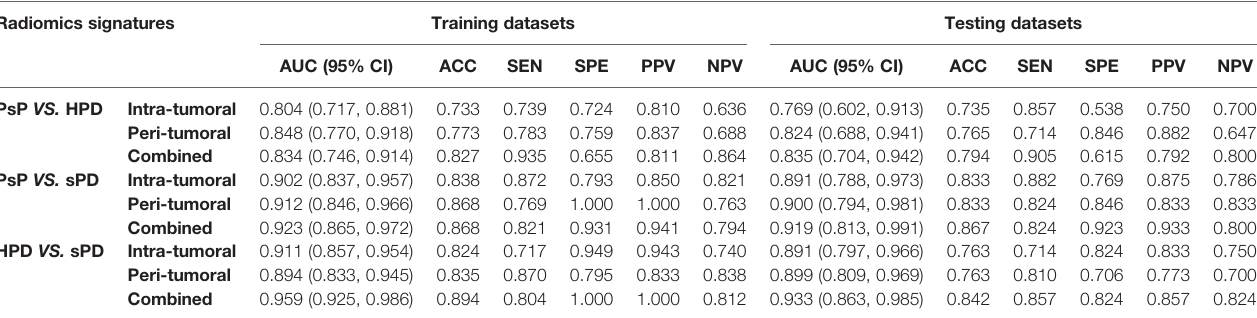
TABLE 4 | The discriminative performance of the models in the training and testing datasets.